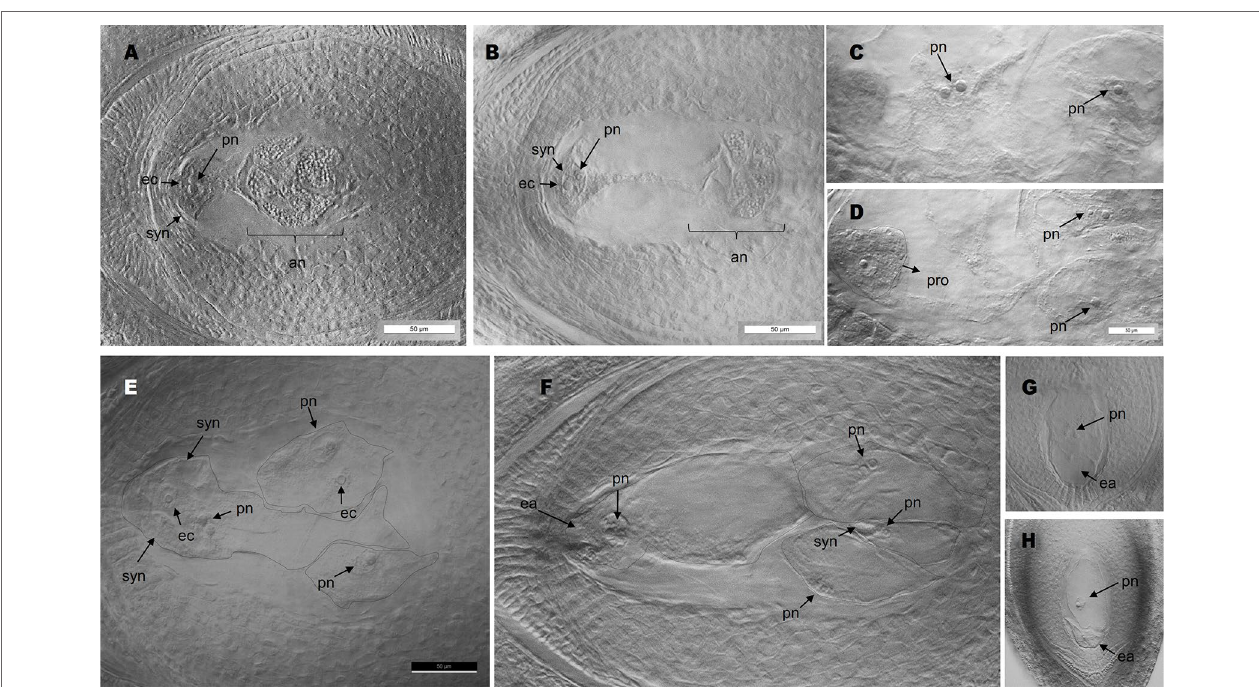
FIGUre 2 | Cytoembryological analysis of antisense and control plants. (A , B) : meiotic embryo sacs with antipodal cells at the chalazal pole (A: wild type; B: plant E2.9). (c , D) : adjacent planes of an ovule of obligate aposporous plant Q4117 carrying non-reduced AES; note the coexistence of proembryos arising from parthenogenesis with non-fertilized polar nuclei. (e , F) : several gametophytes without antipodal cells (AES-like) coexisting in the same ovule (E: plant E2.9; F: plant E2.13) (images of different focal planes are available in Supplementary Data Sheet 3 ). (G , H) : single AES-like gametophyte without antipodal cells (G: plant E2.13; H: plant E2.9). pn, polar nuclei; syn, synergid cells; ec, egg cell; an, antipodal cells; ea, egg apparatus; pro, proembryo.